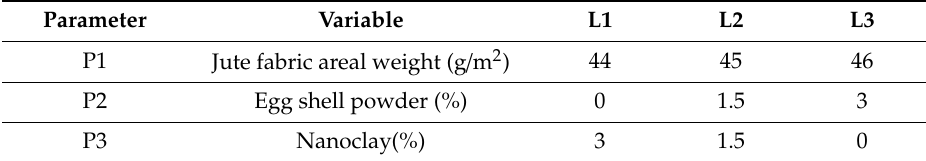
Table 10. Parameters (P) and levels (L) matrix for experimental work.